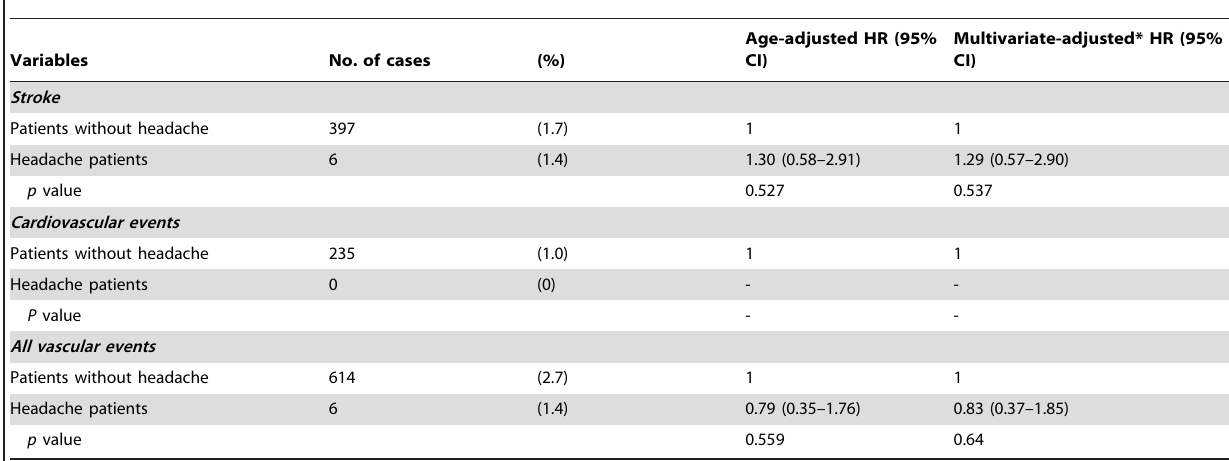
Table 7. Adjusted hazard ratios of vascular events among the ER headache patients and patients without headache (n =23165).